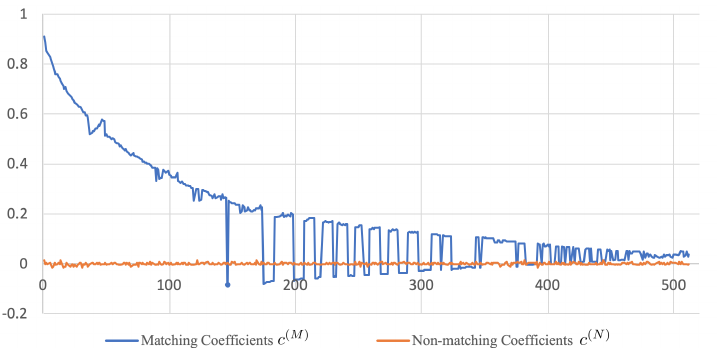
( M ) ( N ) and c , where t ∈ { 1,2, . . . ,512 } ) t t